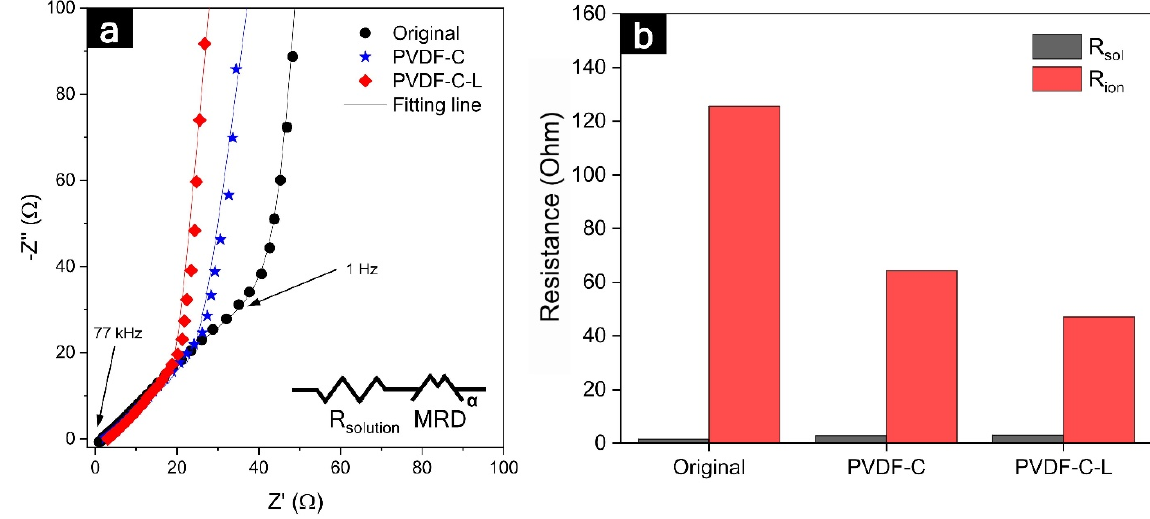
Figure 5. ( a ) EIS data of symmetric pristine electrodes, depending on the carbonization and laser structuring; ( b ) comparison of each resistance component in the graphite electrodes.